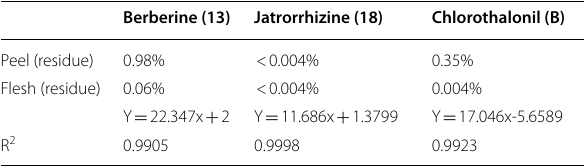
Table 3 HPLC/MS detection sample residue